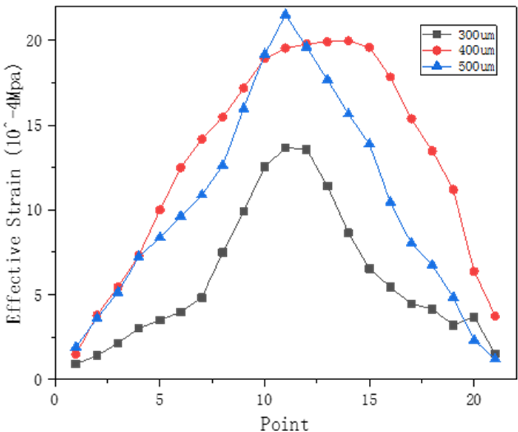
Figure 7. Equivalent strain distribution of scaffolds with different diameters.